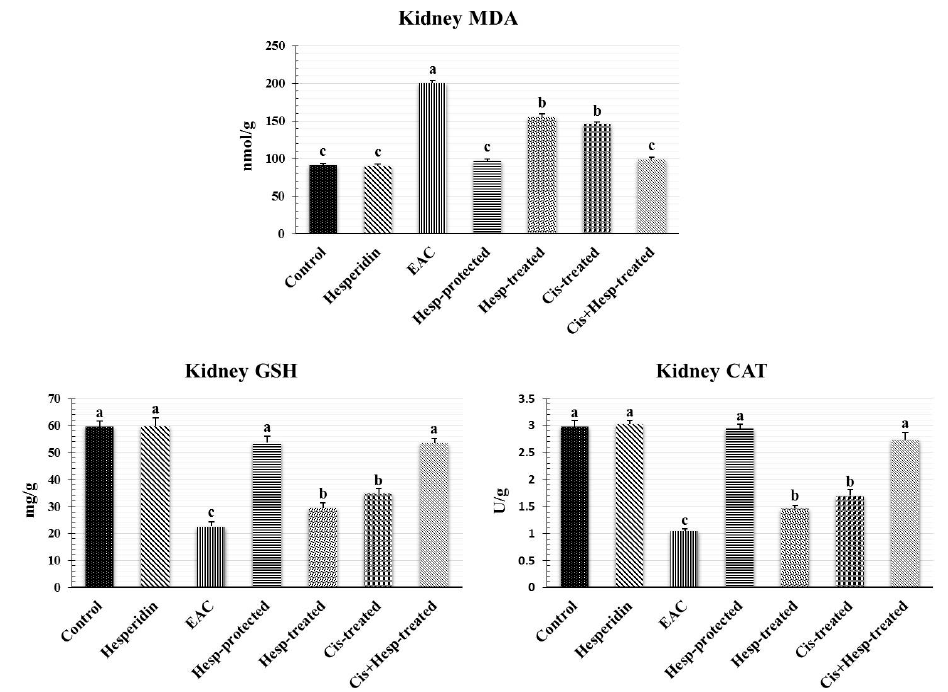
Figure 2. Effect of hesperidin and/or cisplatin on renal oxidant/antioxidant status EAC-bearing mice ( n = 7). Different letters (a, b, c) indicate significant differences at p < 0.05. EAC: Ehrlich ascites carcinoma; Hesp: hesperidin; Cis: cisplatin; MDA: malondialdehyde; GSH: reduced glutathione; CAT: catalase.